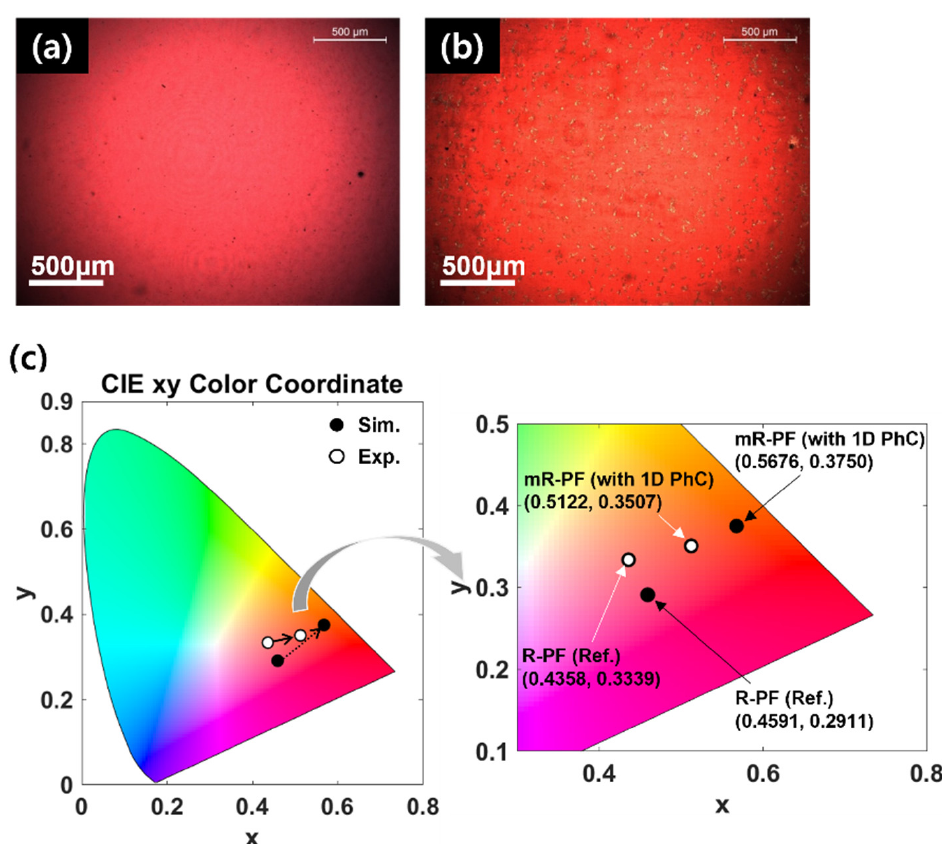
Figure 6. Optical characteristics of the fabricated and simulated PCFs. The microscopic image of the fabricated ( a ) R-PF and ( b ) mR-PF, respectively. ( c ) CIE chromaticity diagram.